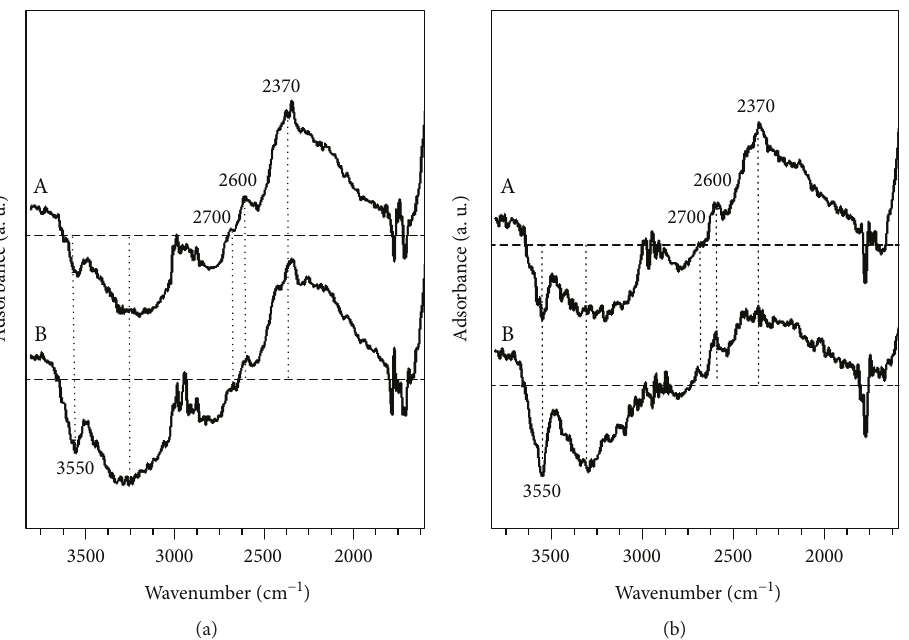
Figure 5: DR-FTIR subtraction spectra in the range 3700 – 1800 cm − 1 of outgassed samples after interaction with D treated by continuous plasma (front of the sponges) and (b) P